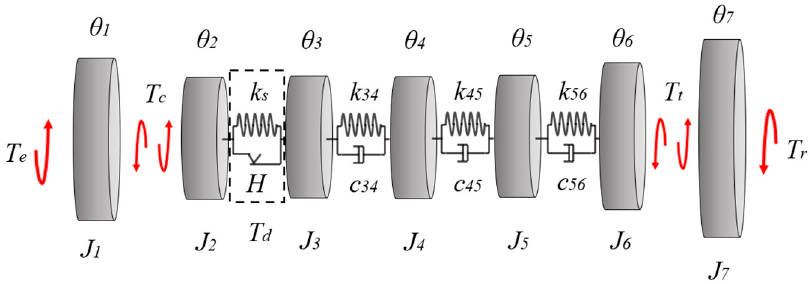
Figure 1. Dynamic model of the driveline system for analyzing the torsional vibration. According to the D’Alembert principle, the differential equations of the model are given as: As the power source of the drivetrain, the output torque of the engine is primarily composed of gas torque, inertia torque and friction torque. Figure 2a illustrates the motion where J , C , K , θ and T are inertia matrix, damping matrix, stiffness matrix, angular of crank-link mechanism and the applied loads. Taking the top dead point as the coordi- displacement vector and torque vector, respectively. They are expressed as nate origin, the displacement of piston 𝑥 (cid:3043) is derived as: